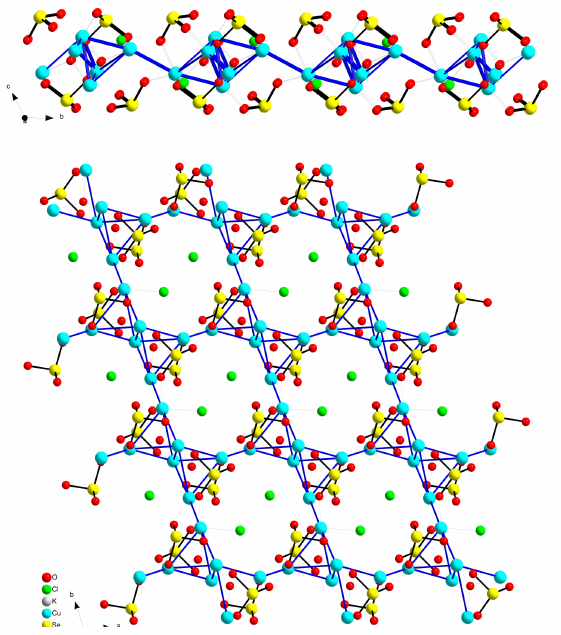
Figure 23. The presentation of the copper-oxygen layer decorated by SeO 32– groups in different directions in the crystal structure of the K[Cu 3 O](SeO 3 ) 2 Cl [65]. Blue lines represent Cu–Cu